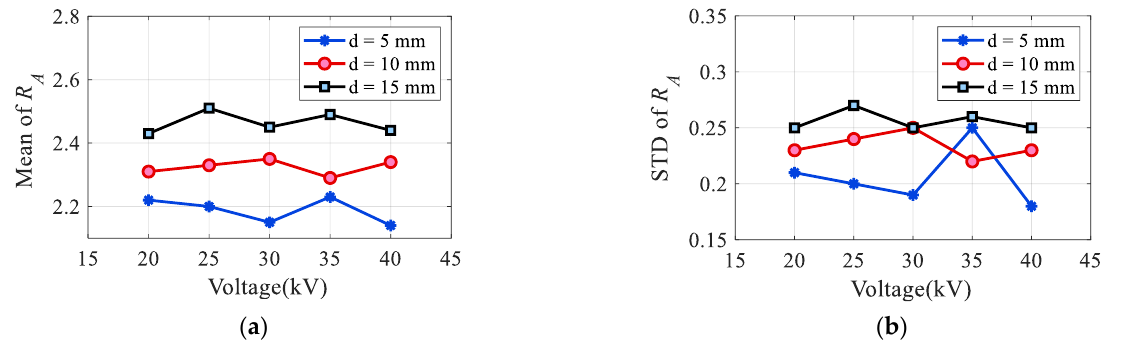
mm; ( b ) U = 25 kV, d = 10 mm; and ( c ) U = 35 kV, d = 15 mm